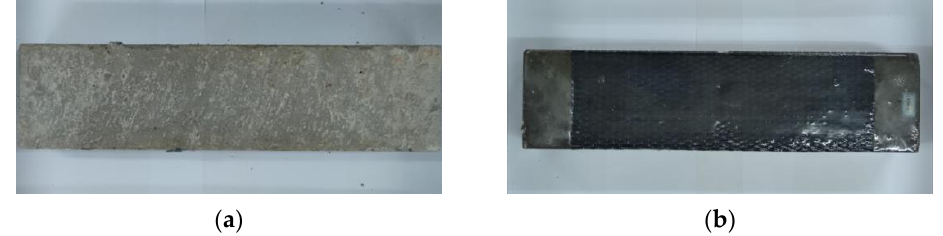
Figure 5. Concrete flexural specimen: ( a ) unreinforced specimen and ( b ) reinforced specimen.